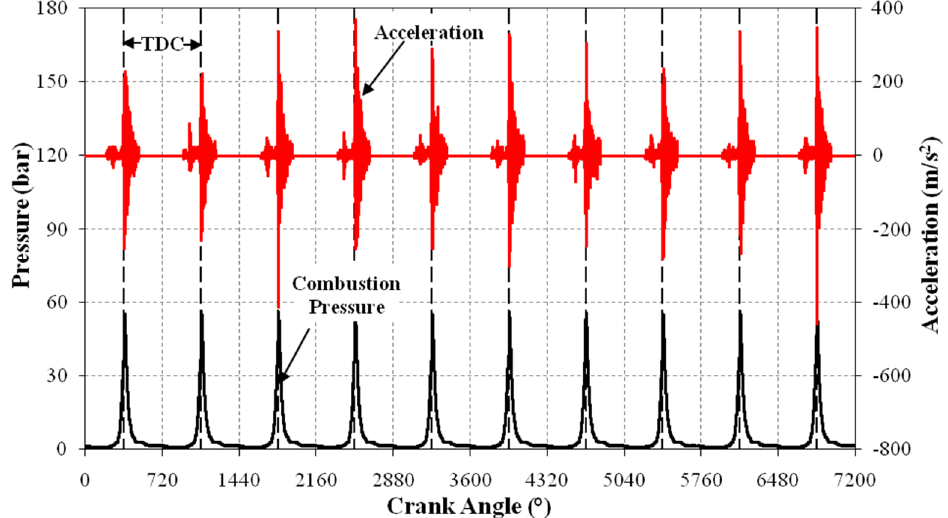
Figure 6. Filtered vibration acceleration wave form and combustion pressure as a function of crank angle for 10 consecutive combustion cycles (diesel fuel).